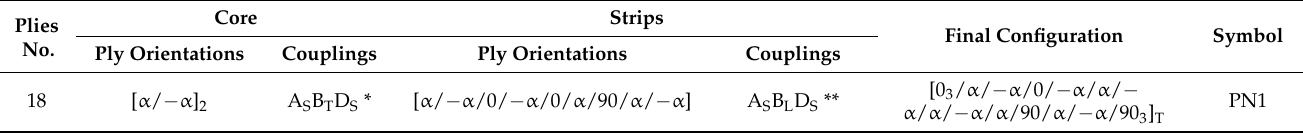
Table 1. Tested laminate configuration.